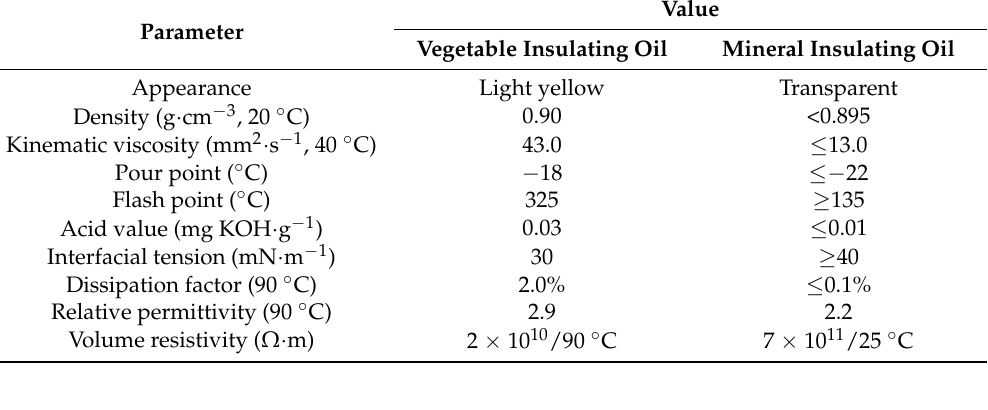
Table 1. Basic properties of insulating oils.